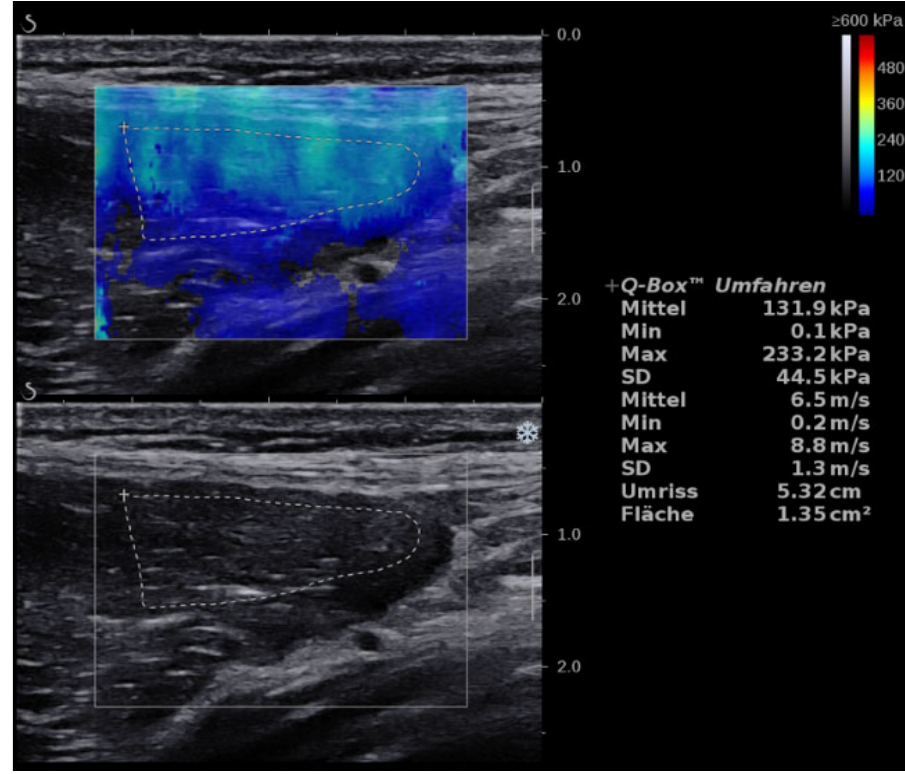
Figure 2. Longitudinal scan of the TFL muscle showing SWE and B-mode with a mean of 6.5 m/s. (the same patient with ITBS as in Figure 1).